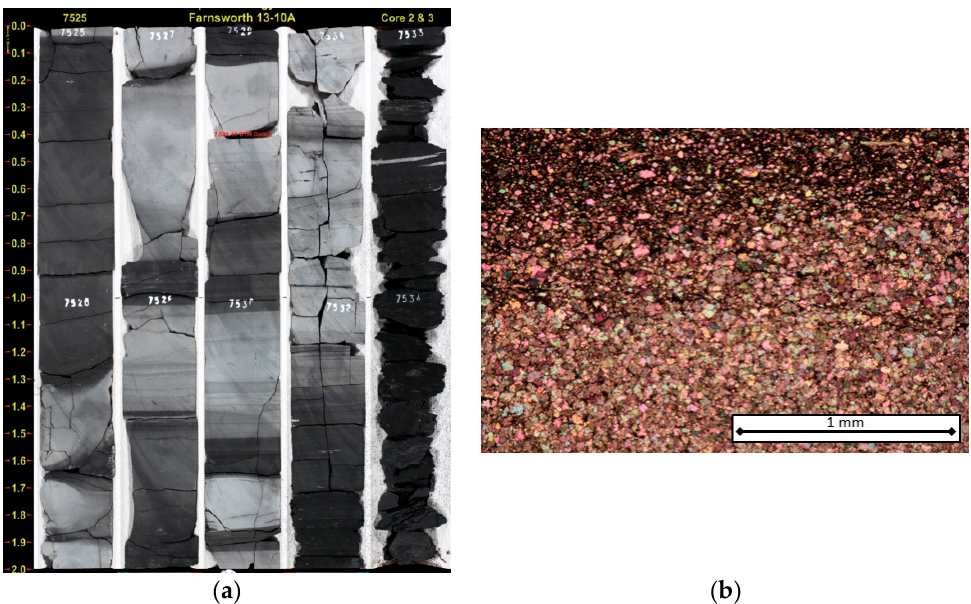
Figure 7. Core from well 13-10A ( a , left) showing finely interbedded cementstone (light gray) and mudstone (dark or black) lithologies of the Thirteen Finger limestone; ( b , right) thin section photomicrograph in cross-polarized light, showing the finely interbedded nature of the mudstones (upper portion of slide) and cementstones [53] (lower portion). Thirteen Finger Limestone